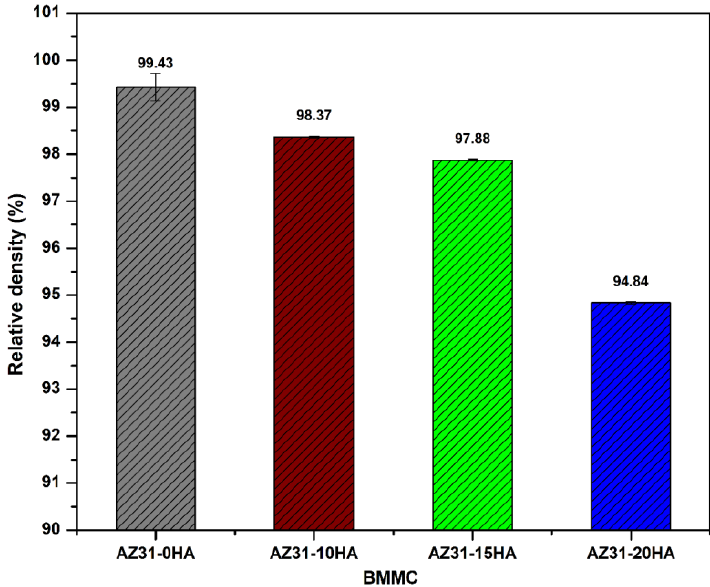
Figure 4. Relative density of microwave-sintered AZ31-HA BMMCs.